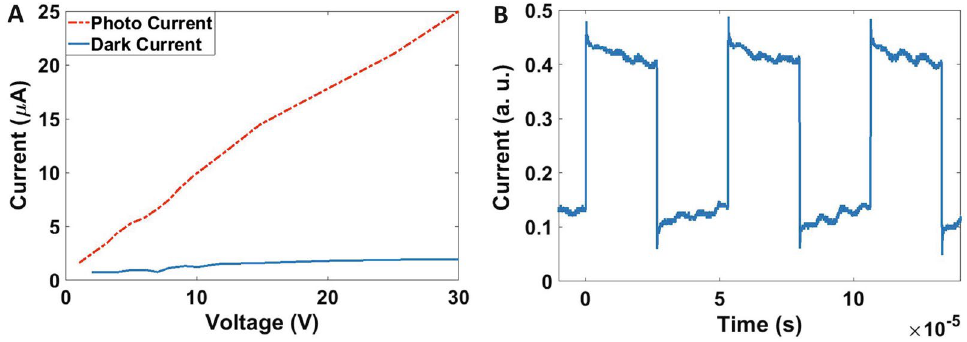
Figure 5. Experimental results for fabricated material. ( A ) The I–V and ( B ) response time of the detectors made by PbSe/PbI 2 QDs.